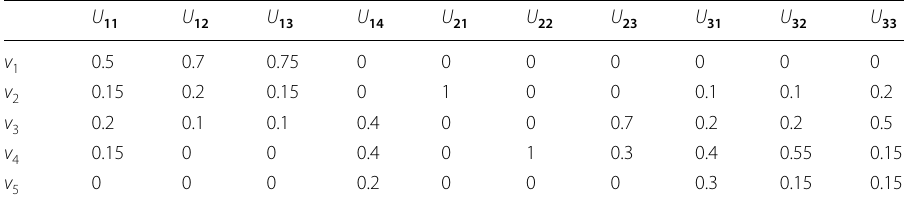
Table 6 Evaluation result of clipping